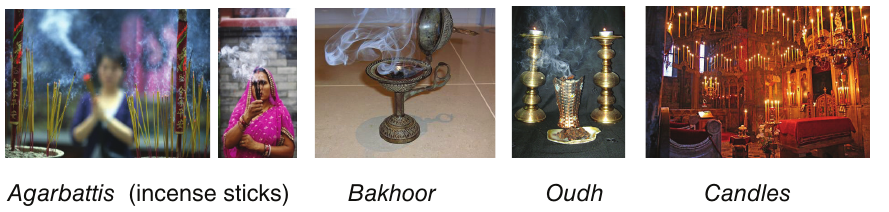
Figure 4. Fragrances used across the globe and their contribution to air pollution. Adapted from Cohen R et al. 21 .